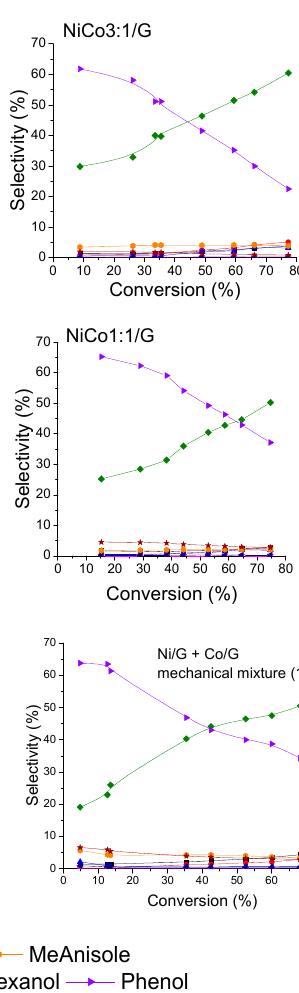
Figure 7. Distribution of the products obtained for each catalyst at 300 °C, 5.0 MPa compared at the same conversion.